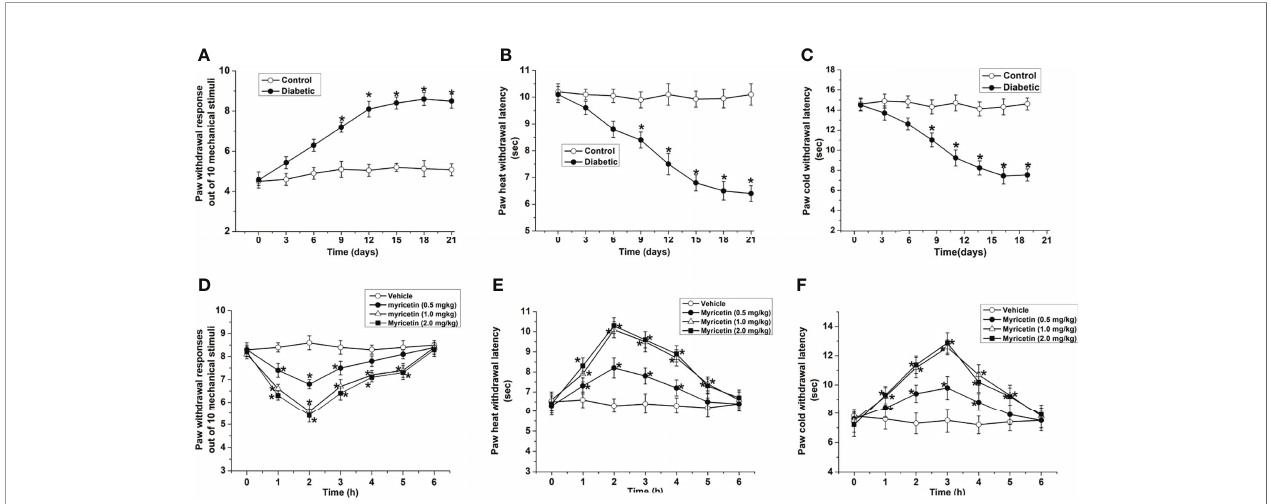
FIGURE 1 | Myricetin ameliorates diabetic mechanical hyperalgesia, heat hyperalgesia, and cold allodynia ( n = 10 for each group). The paw withdrawal response out of ten mechanical stimulations (A) was signi fi cantly increased, and the paw withdrawal latencies to heat (B) and cold stimulation (C) were signi fi cantly decreased by STZ treatment, indicating the development of DPN. * p < 0.05 for the comparison to normal group. Myricetin signi fi cantly decreased the paw withdrawal response out of 10 mechanical stimuli (D) , and increased the paw withdrawal latency to heat (E) and cold stimuli (F) in diabetic rats. * p < 0.05 for the comparison to the saline-treated diabetic